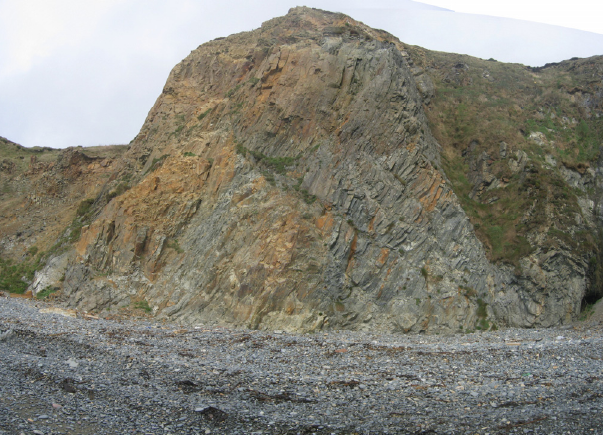
Figure 8. Pipes of Baidhb, County Waterford: polygonal columns in rhyolite intrusion.